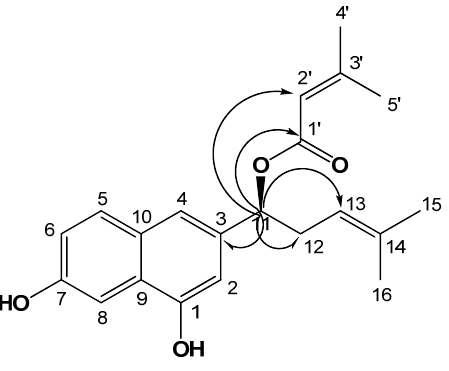
Figure 1. Chemical structure of compound 1 isolated from the Lithospermi radix and key gHMBC ( arrow ) correlations of compound 1 .